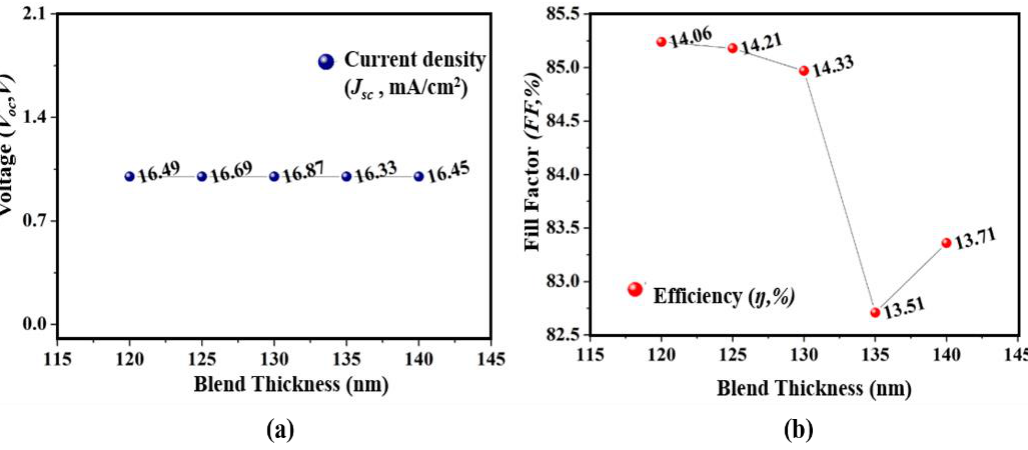
Figure 3. Effect of second absorber layer thickness on photovoltaic parameters. ( a ) V oc and J sc ; ( b ) FF and η .